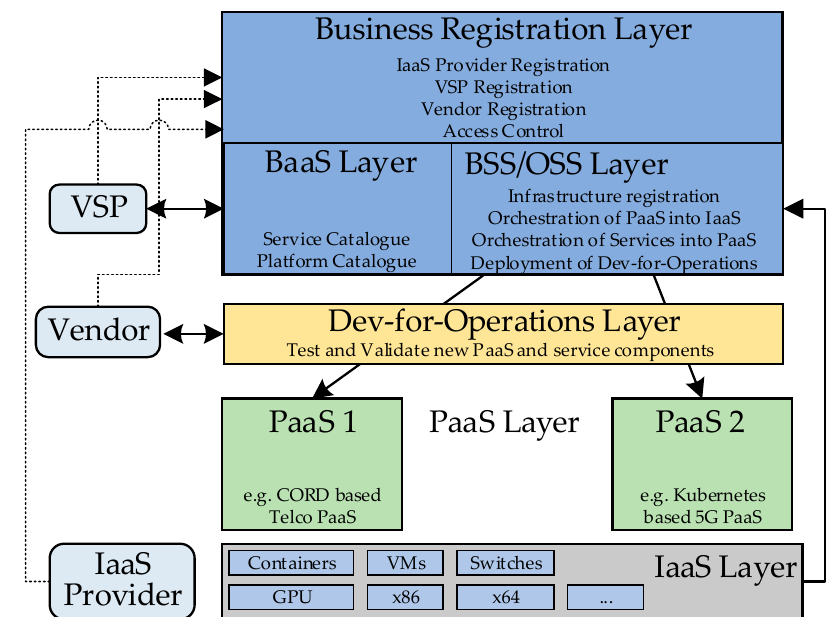
Figure 1. Simplified view of the NGPaaS architecture.